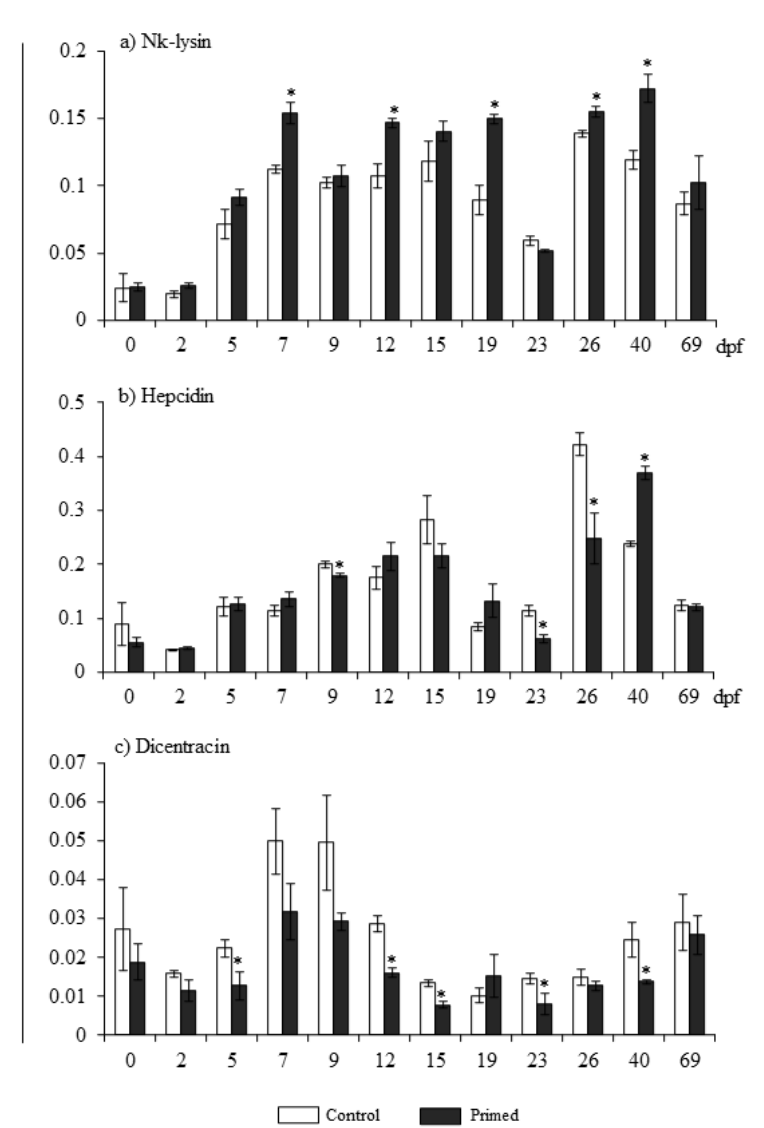
Figure 3. Protein levels of Nk-lysin ( a ), Hepcidin ( b ), and Dicentracin ( c ) in eggs (0 or 2 dpf) and larvae (5 to 69 dpf) homogenates from control or primed females’ progeny. Data represent the mean ± SEM ( n = 3). Asterisks denote statistical differences with controls ( p ≤ 0.05). dpf denotes days post- fertilization.